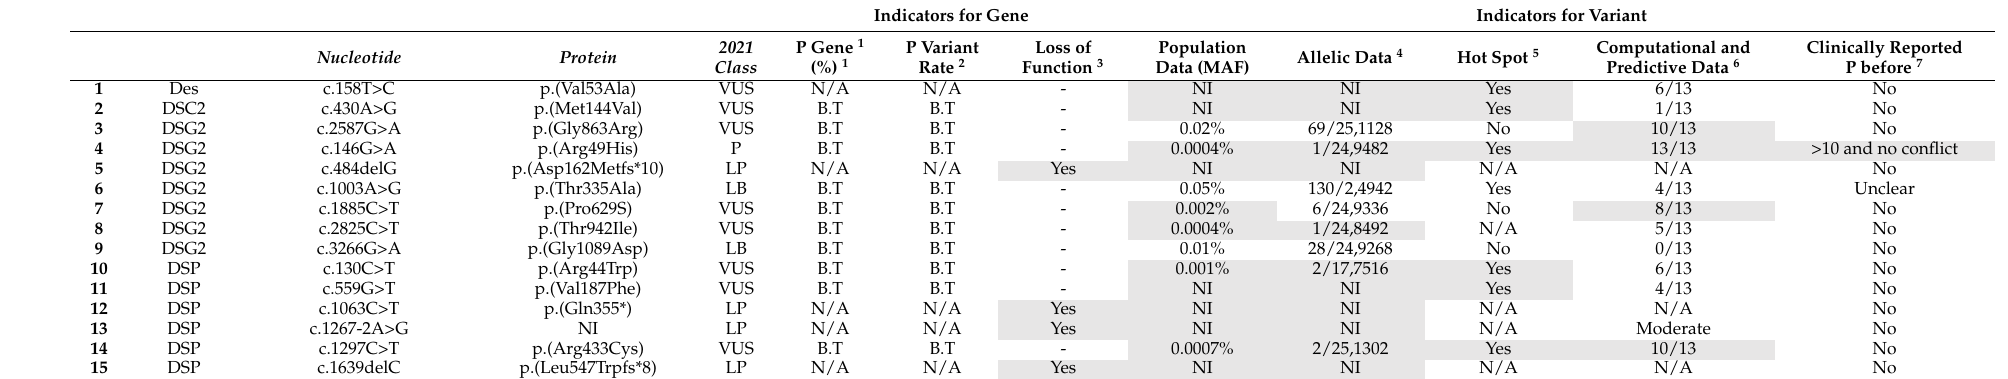
Table 2. Most relevant indicators in the